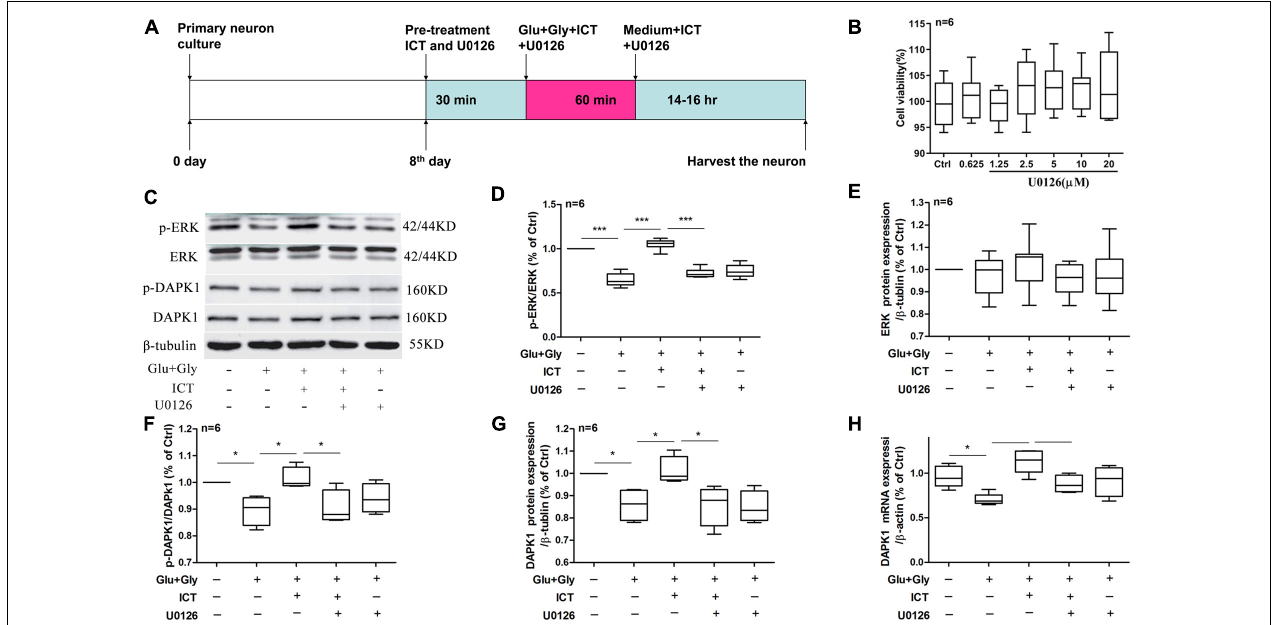
FIGURE 4 | The rescuing effect of ICT on the phosphorylation of ERK and DAPK1 and DAPK1 expression post-glutamate injury is hindered by the inhibition of ERK. Timeline for the rat primary cortical neurons glutamate-induced injury model treatment with ICT and U0126 (A) : to clarify the role of ERK in the effect of ICT on neuroprotection and the functions or expression levels of DAPK1, GluN2B and GluN2A, primary neuronal cultures were treated with ICT and U0126, a specific inhibitor of ERK, from 30 min before glutamate injury until the cells were harvested 14–16 h after injury. The effects of different concentrations of U0126 on cell activity were detected, and the results showed that U0126 had no significant effect on the viability of normally cultured neurons (B) . Western blot and RT-qPCR were performed to analyze p-ERK, ERK, p-DAPK1 and DAPK1 protein expression (C–G) and DAPK1 mRNA levels (H) from five treatment groups: control, Glu+Gly,